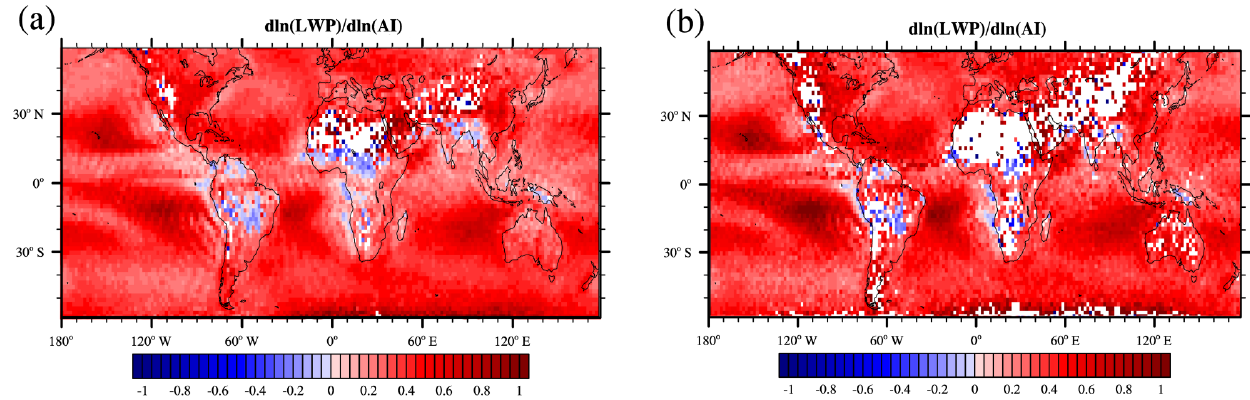
Figure A1. LWP response to changes in AI for ECHAM6-HAM2 (1995–2011). (a) For 3h sampling, (b) for daily (10:30 local time)